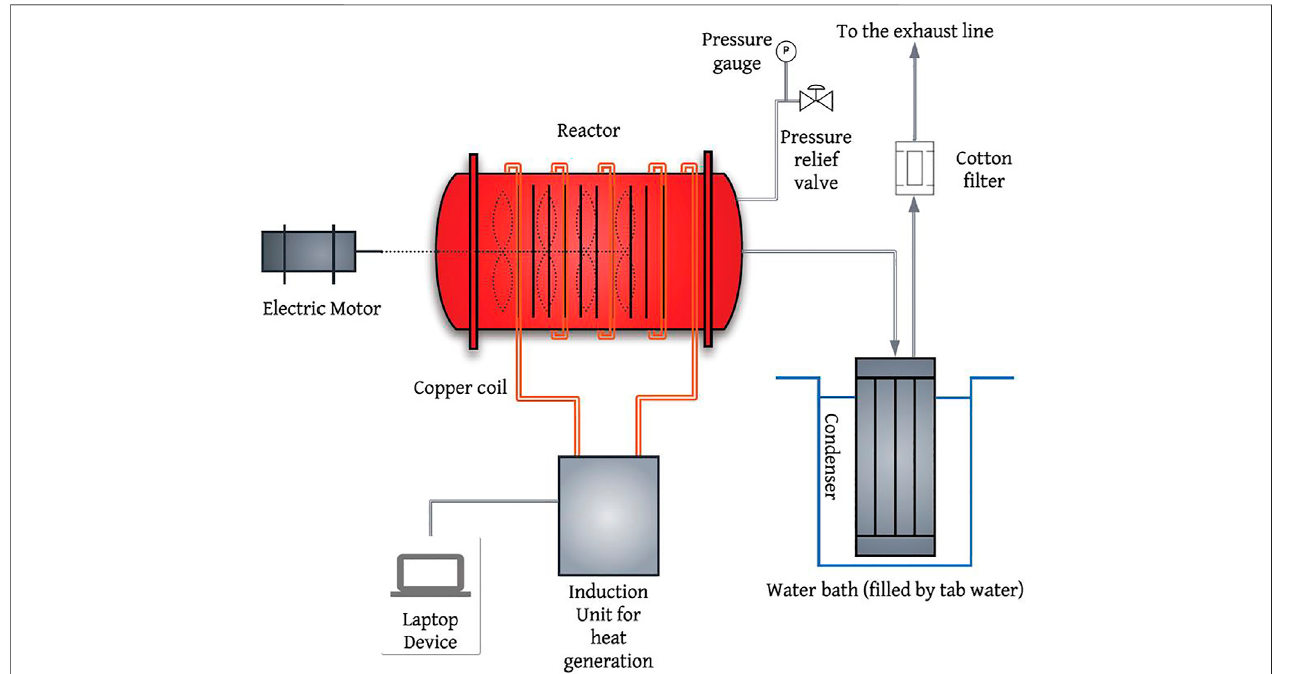
FIGURE 1 | Process Flow Diagram (PFD) of mechanically mixed reactor (adapted from (Karami, 2021)).